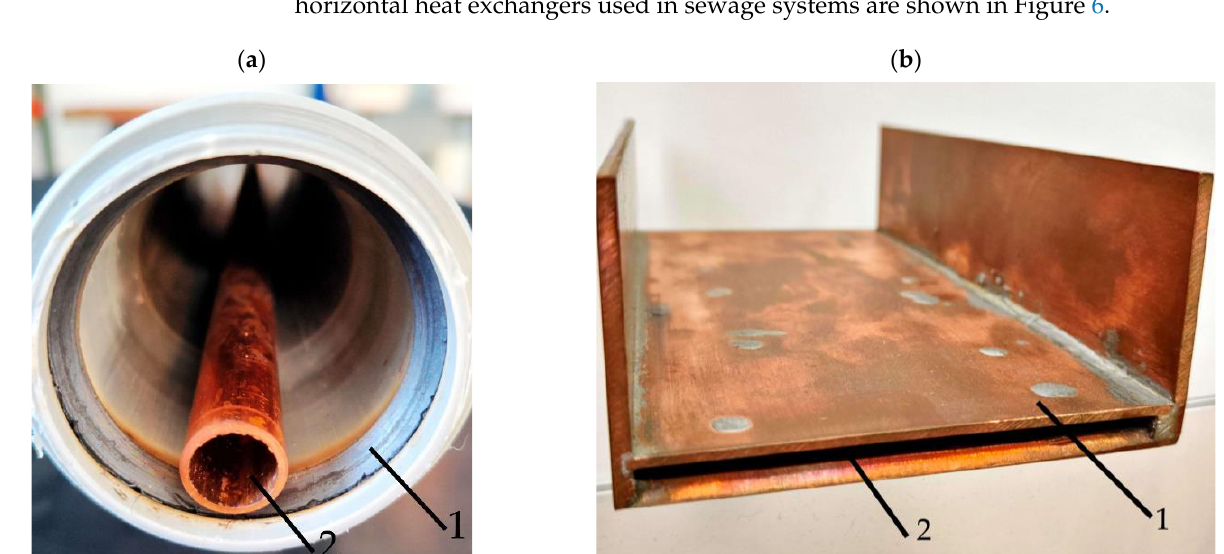
Figure 6. Typical cross-sectional views of horizontal heat exchangers. 1 — grey water drain, 2 — cold water drain. ( a ) Grey water and cold water drains with circular cross-sections, ( b ) grey and cold water drains with a rectangular cross-section.